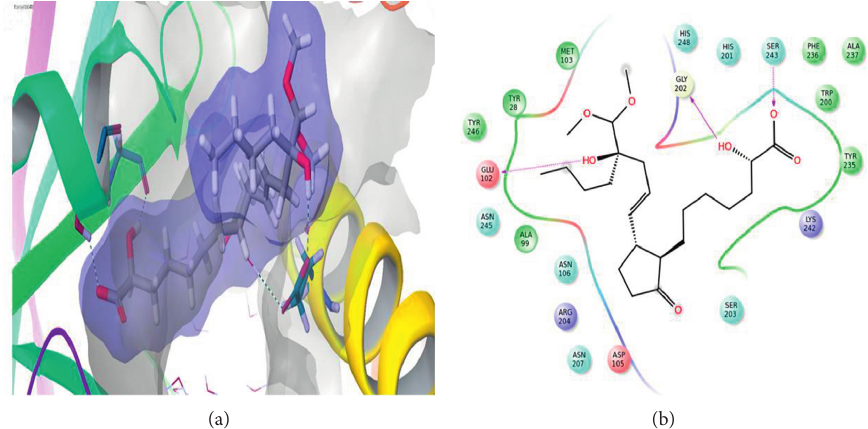
Figure 6: Docking complex of CXCR4 with compound 2 generated using Glide XP module of Schr¨odinger suite is shown in this figure. The proteins, ligand, and binding pockets are represented in ((a) 3D graphics) ribbon, sticks, and surface models, respectively. The residues of the CXCR4 that are within 4 ˚A proximities to compound 2 are illustrated in (b) 2D graphics. Dotted lines denote “hydrogen bonds” between the corresponding atoms.